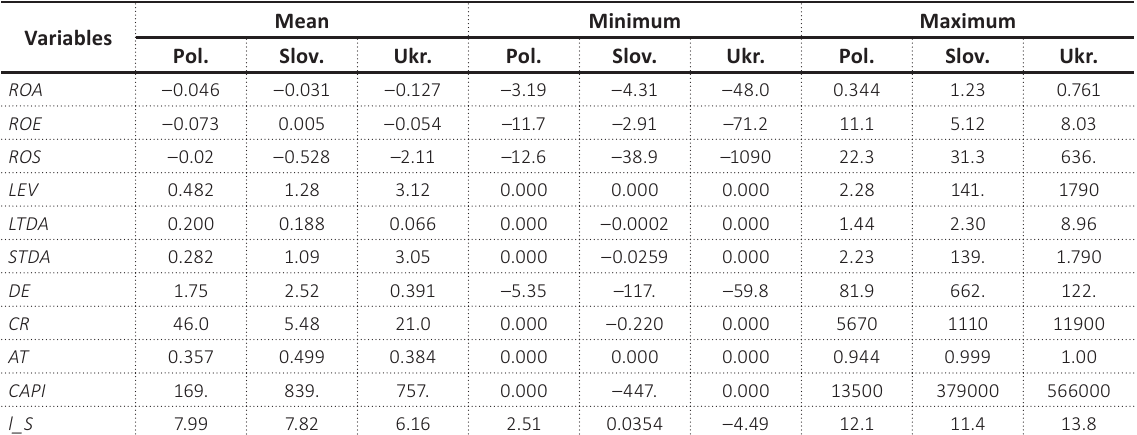
Table 2. Descriptive statistics (based on observations: 1:1 – 34:4 (Poland); 1:1 – 123:4 (Slovakia); 1:1 – 305:4 (Ukraine))